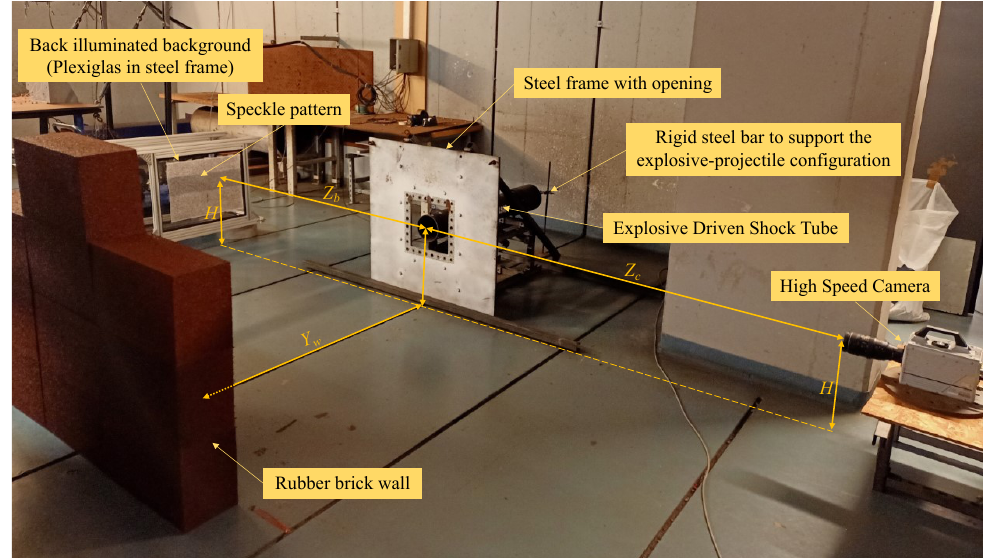
Figure 2. Image of the experimental setup using the EDST showing the instrumentation used to visualize the passage of the blast wave front and the projectile at the exit of the